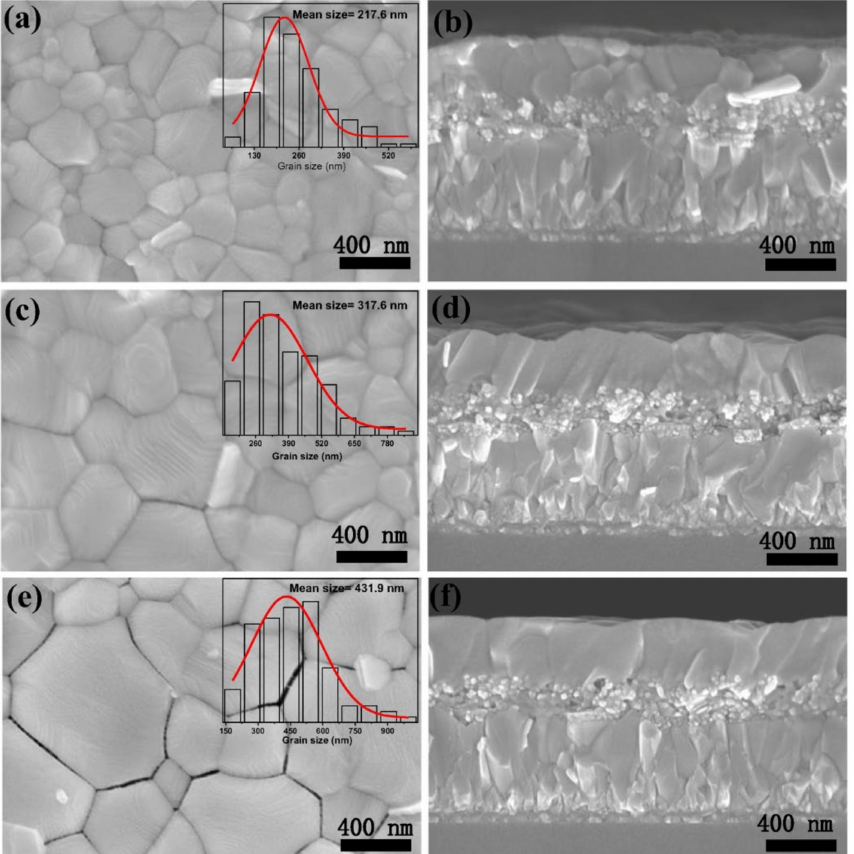
Figure 5. Surface (left) and cross-sectional (right) SEM images of the MAPbI 3 perovskite films annealed at different temperatures. ( a , b ) 100 ◦ C for 20 min; ( c , d ) 175 ◦ C for 60 s; ( e , f ) 250 ◦ C for 10 s; insets show the grain distribution of the corresponding perovskite films. Reprinted with permission from Ref. [18]. Copyright 2018 Elsevier